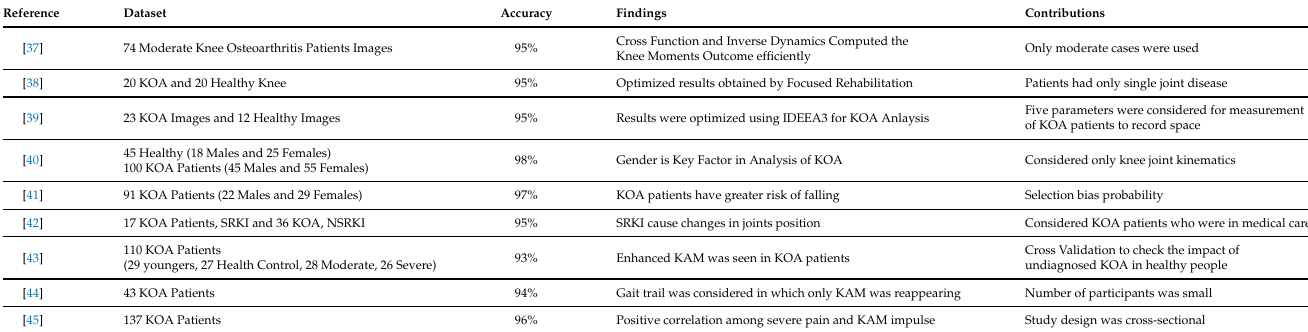
Table 1. Summary of recent studies on the detection of Knee